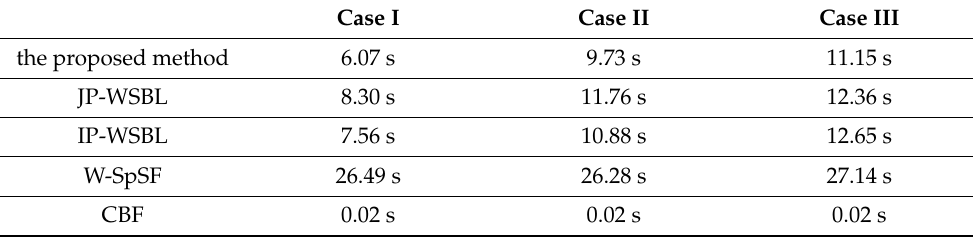
Table 1. Mean running time of each method under three different frequency cases.